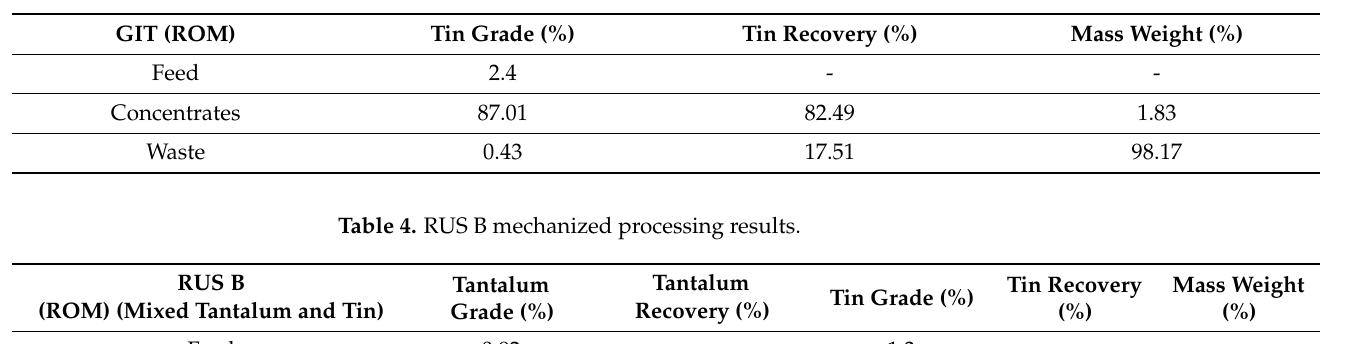
Table 3. GIT mechanized processing results.